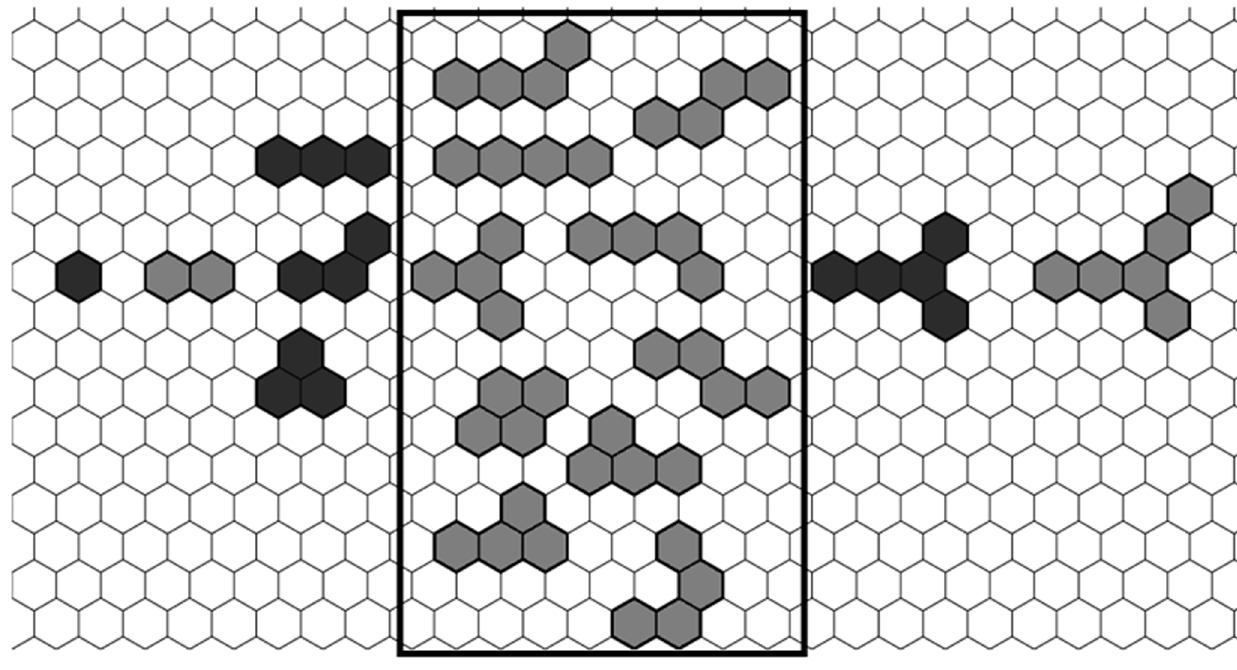
Figure 3. The examples of benzenoids composed of 1–6 benzene rings on a hexagonal lattice.